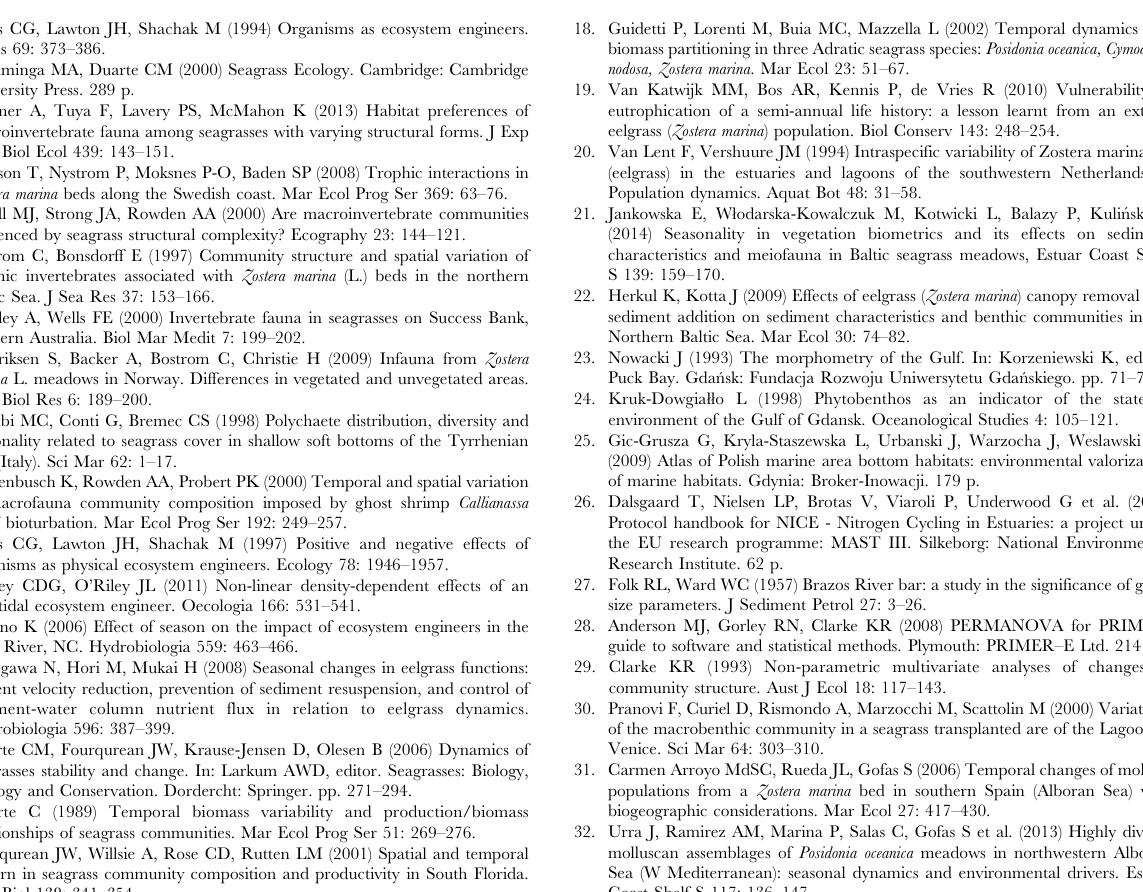
Table S1 Taxonomic composition and densities of taxa in samples collected at two stations, on two bottom types and in five months. Average values for replicate samples collected at the same stations, bottom types (veg - vegetated bottom, unveg - bare sands) and months are presented.